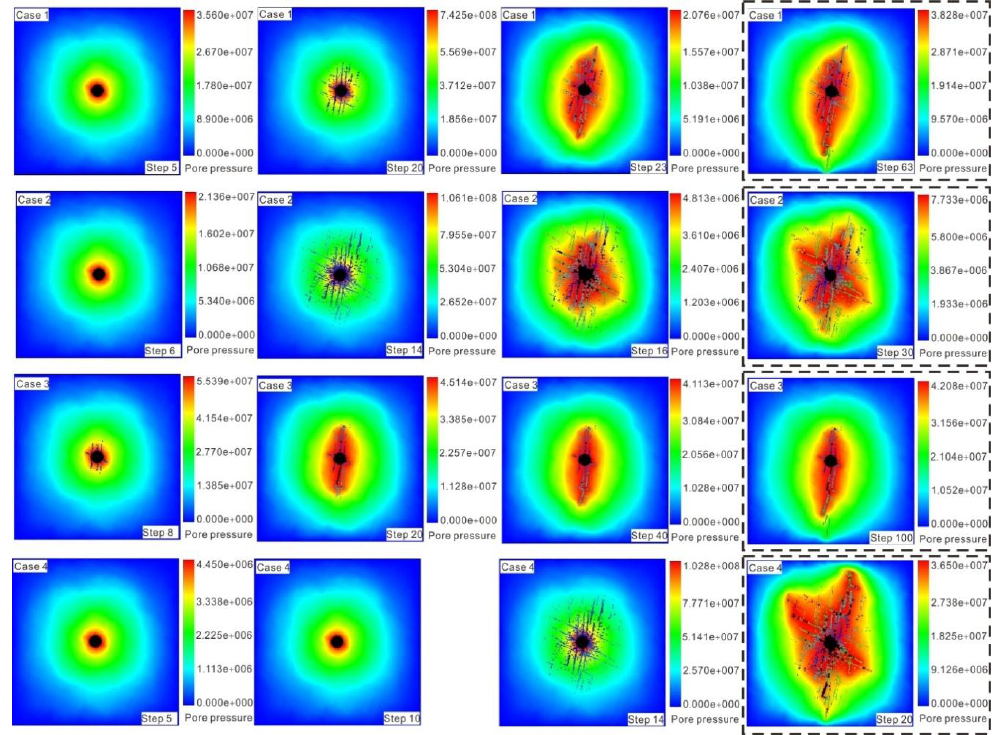
Figure 3. General observations of the fracking process for the four cases at each hydraulic fracturing stage (Color shadow indicate relative magnitude of the pore water pressure field). stage (Color shadow indicate relative magnitude of the pore water pressure